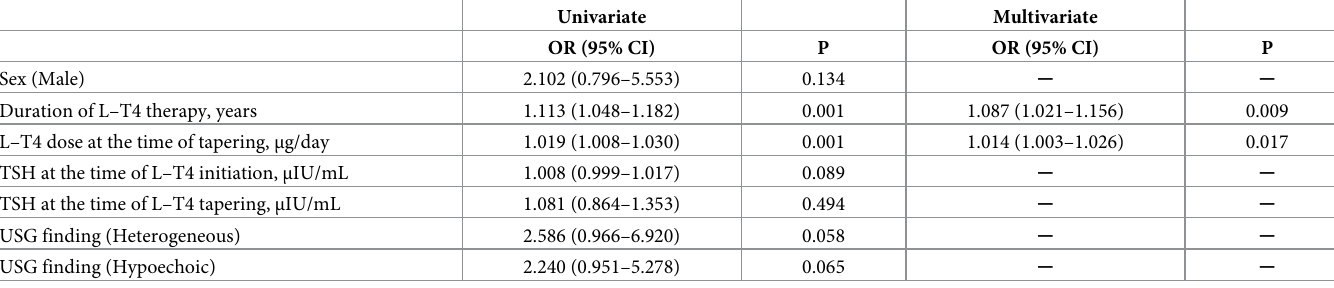
Table 2. Predicting factor for failure to discontinuation of L–T4 therapy.